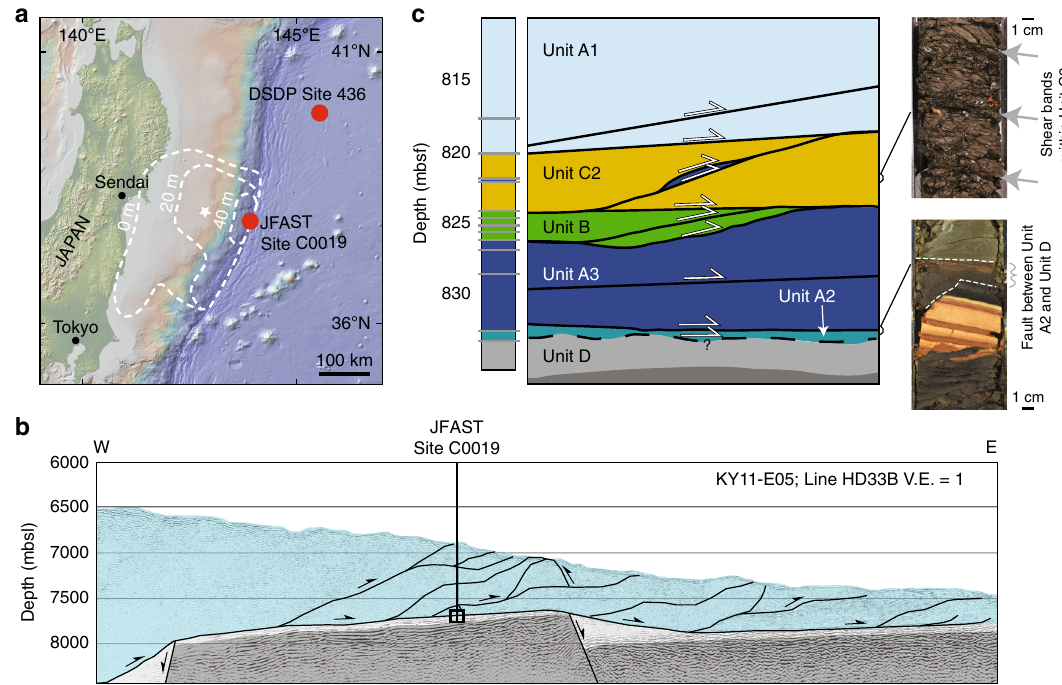
Fig. 1 Location and structure of the JFAST core. a Map of the Japan Trench with the JFAST and Site 436 sites identi fi ed by red dots. White dotted contours indicate regions of equal slip during the Tohoku-Oki earthquake as inferred by geophysical data 12 – 15 . b Schematic structure of the accretionary prism perpendicular to the trench recovered at JFAST traced over a seismic section 16 , and c close-up of the schematic JFAST stratigraphy with interpreted structure 17, 18 and pictures of typical structures from regions of the core where damage has been